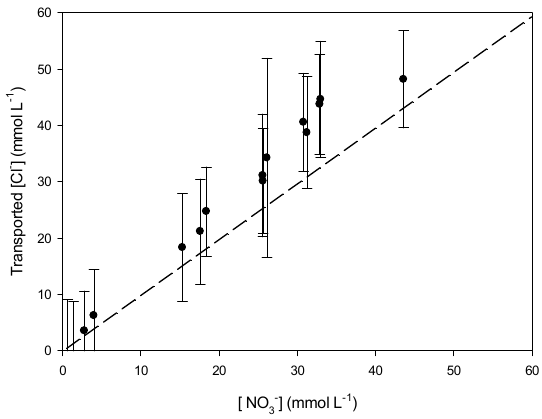
Figure 10. Comparison of the transported [Cl − ] into the feed phase and [NO 3 − ] into the receiving phase using PIM-8.